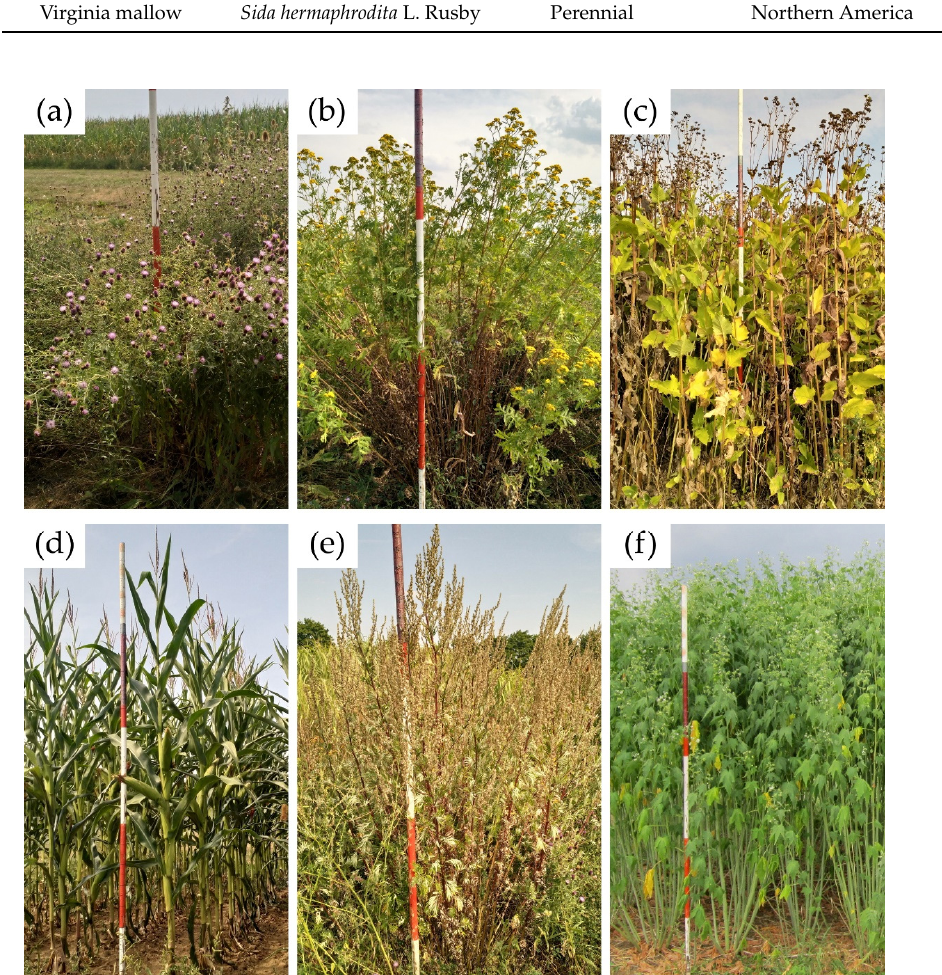
Figure 1. Overview of the crop species investigated in this study: ( a ) common knapweed ( b ) common tansy ( c ) cup plant ( d ) maize ( e ) mugwort and ( f ) Virginia mallow. This field trial was established in a randomized block design with three (maize, Vir- ginia mallow, cup plant) and five replicates (WPM), respectively, in 2014. The plots were of square shape and their gross area was 36 m 2 . The distance between the plots was 1.5 m, and the distance between the blocks was 5 m. The site is characterized by homogeneous favorable abiotic growth conditions, such as (i) clayey loam (Luvisol) [36], (ii) an average annual air temperature of 10.1 °C in 2016 (Figure 2), 1.4 °C higher compared with long- term data, and (iii) an annual precipitation of 595 mm in 2016 (Figure 2), which was 103 mm less compared with long-term data. The harvest dates of the biomass samples for this study varied according to the crop-specific demands. The WPS (common tansy, common knapweed and mugwort) and Virginia mallow were harvested in August 2016. Cup plant and maize were harvested in October 2016. Only fully developed individual plants from the WPM plots were selected for harvest of the WPS, with three plots each found for com- mon tansy and common knapweed, but only one plot for mugwort. For cup plant, only plant samples of two randomly selected representative plots of the three existing plots were chosen due to technical reasons. For all crops, harvesting was done by hand using a pruning shear.